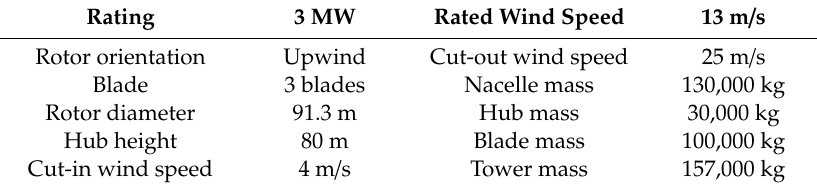
Table 3. Specifications of WinDS3000 wind turbine.